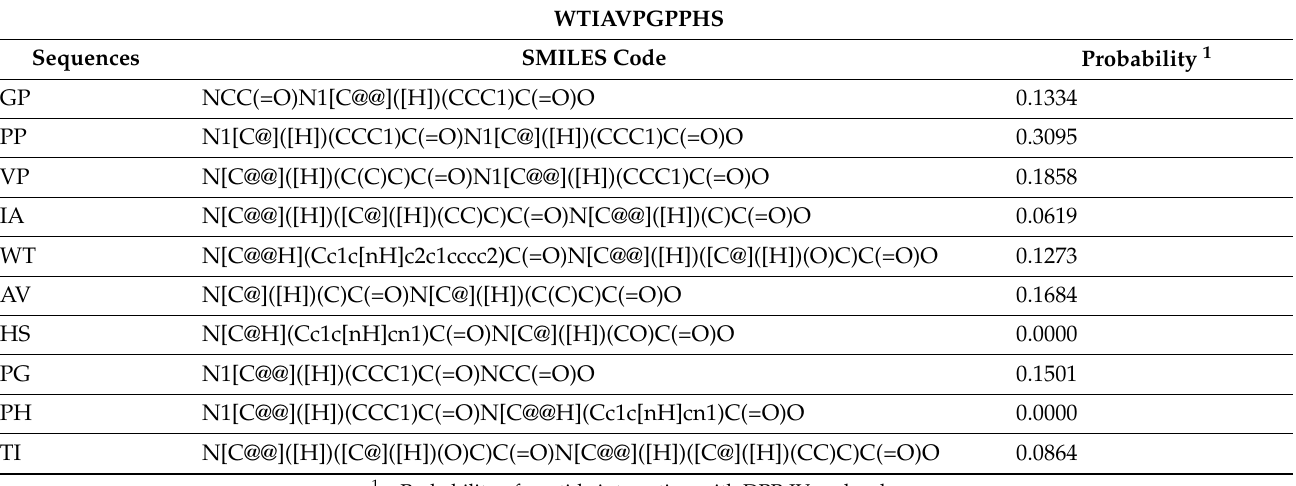
Figure 2. Family of target proteins from the WTIAVPGPPHS and FKRPPL peptides based on the SwissTargetPrediction tool. Table 3. The result of predicting the likelihood of bioactive small peptides acting as DPP-IV ligands.